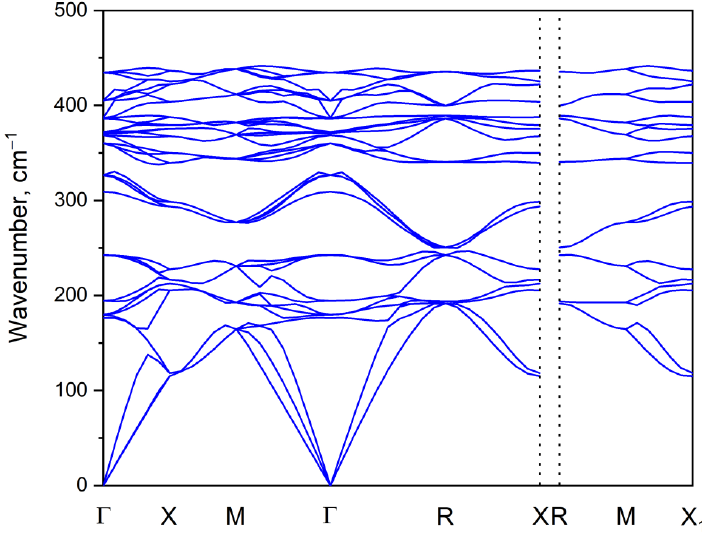
Figure 9. Ab initio calculated phonon dispersion curves of the Brillouin zone of RuS 2 laurite structure plotted along major directions.